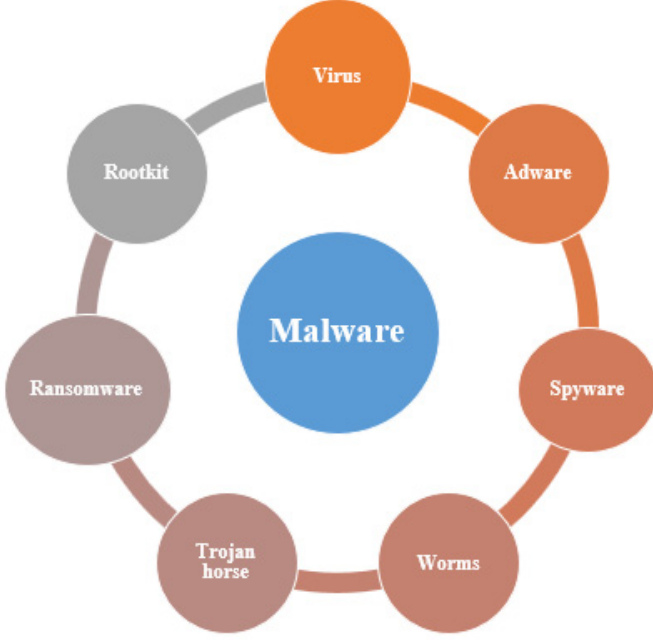
Figure 2. Malware types.